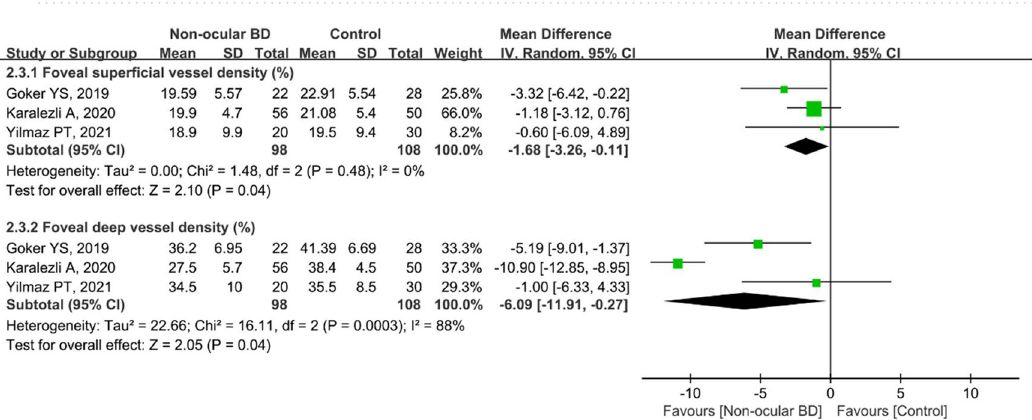
Figure 6. Forest plot analysis of foveal superficial and deep vessel density between eyes with ocular BD and the controls.